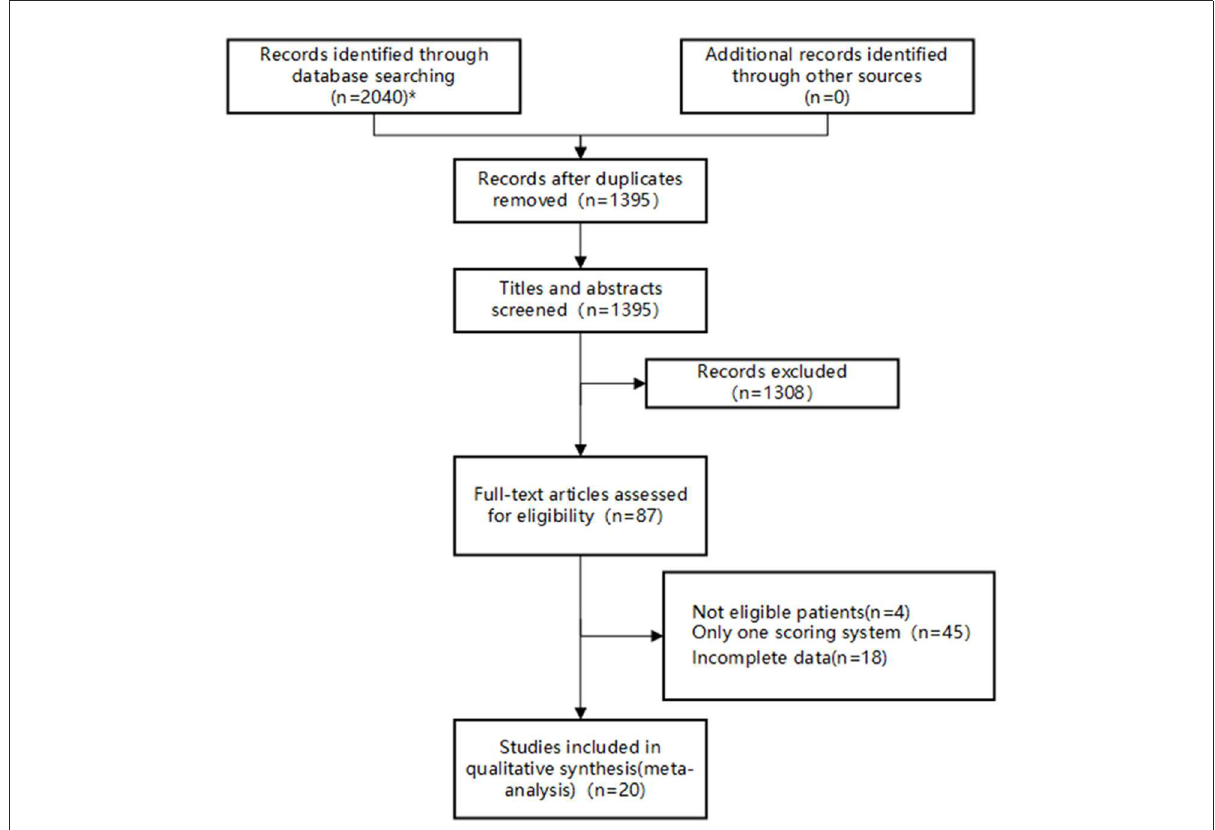
FIGURE1 Flow diagram of study inclusion. *The databases searched and the number of studies retrieved are as follows: PubMed ( n = 826), Embase ( n = 48), Web of Science ( n = 769), CNKI ( n = 40), Wan Fang Data ( n = 70), VIP ( n = 254), and SinoMed ( n =